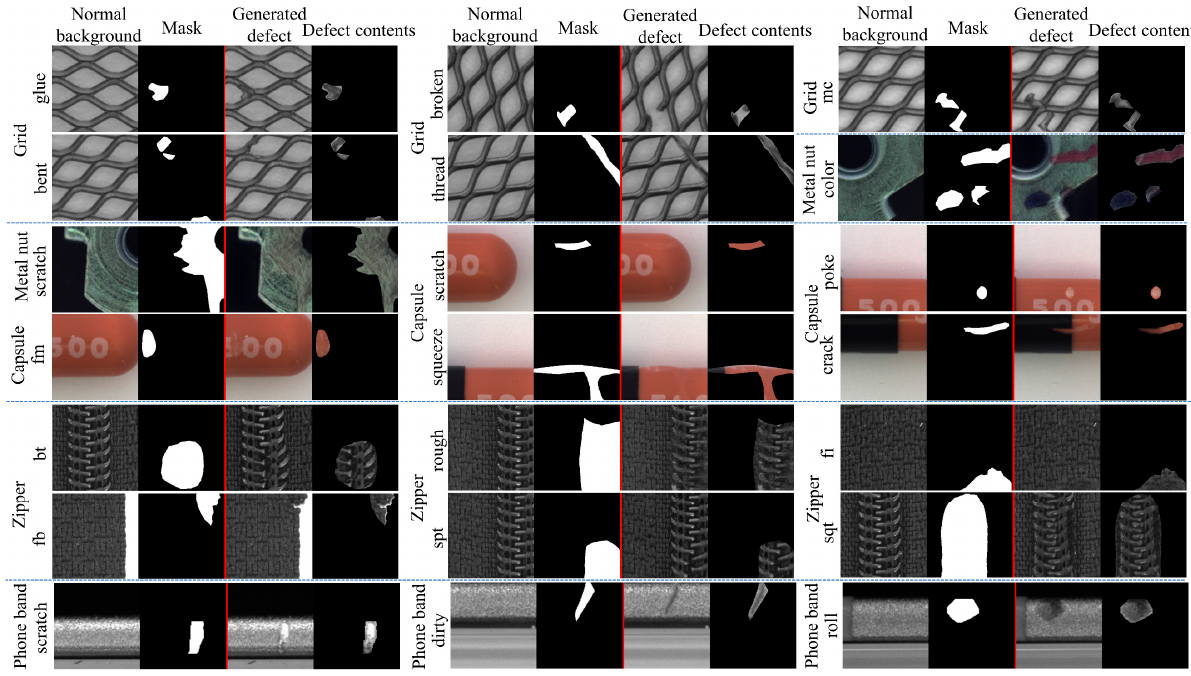
Figure 5. Synthesis results for each item. Normal background indicates the real background image, Mask is the corresponding binary mask, and both were input into the generator to obtain the synthetic defect image Generated defect . Defect contents were segmented by the Mask from the Generated defect .